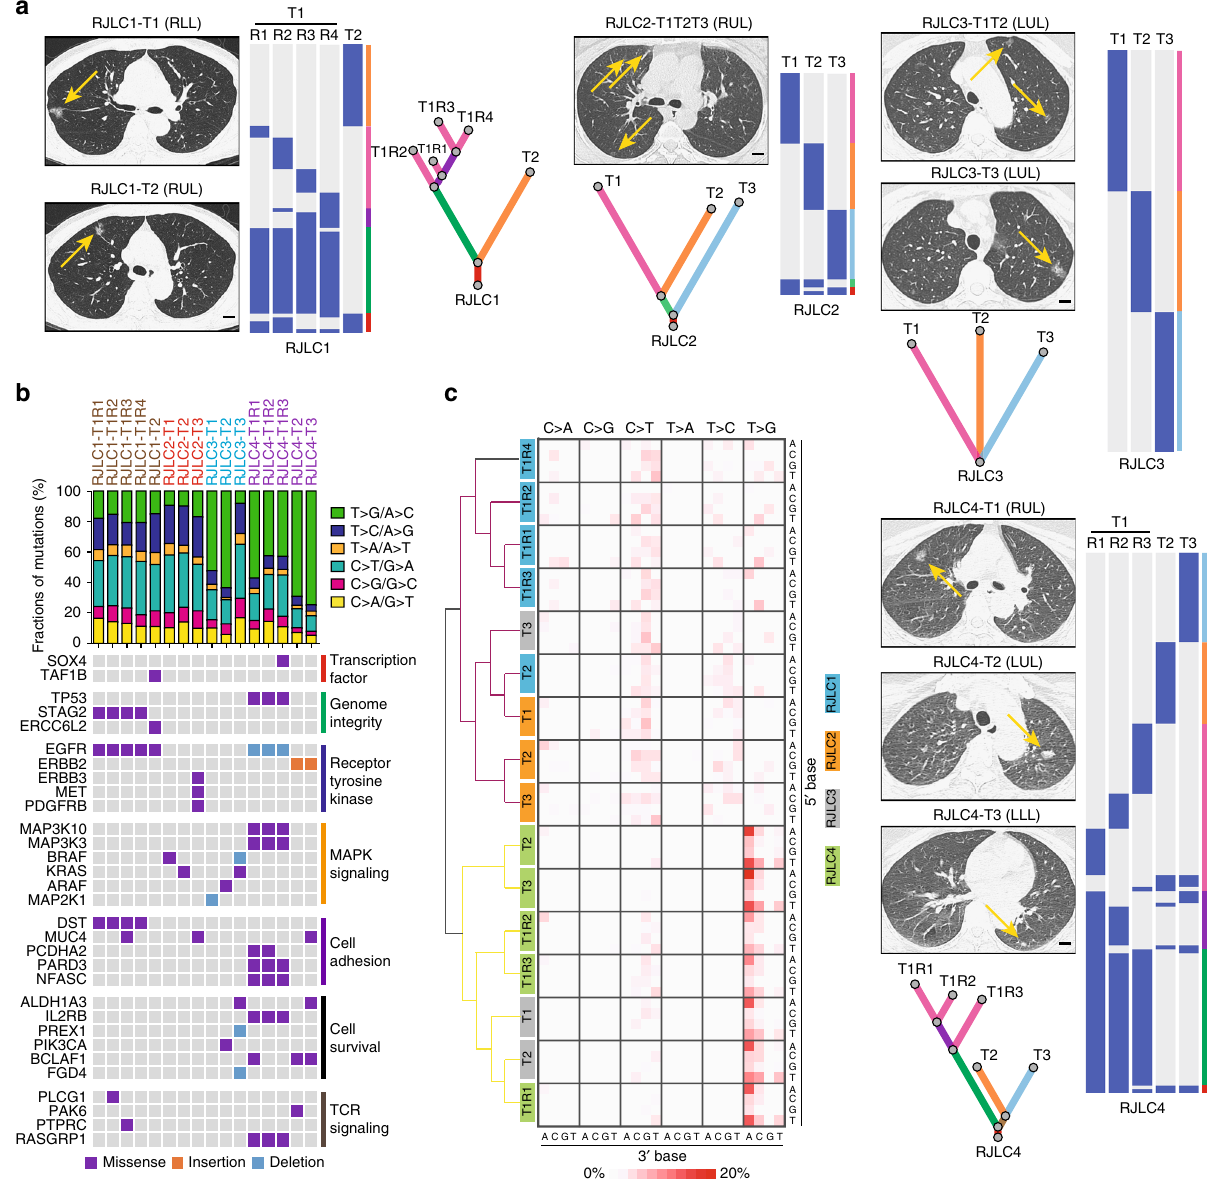
Fig. 1 Clonal architecture and mutational landscape of MSLC. a Computed tomography (CT) diagnosis and clonal architecture of multifocal tumors in four MSLC patients. Heat maps showed the presence (blue) or absence (gray) of all non-silent somatic mutations in every tumor region. Phylogenetic trees indicated the clonal structure of sequenced tumor regions in each patient. Scale bar, 1 cm. b Mutational landscape of all 16 sequenced tumor regions. Putative driver genes with somatic mutations were classi fi ed according to the functional categories. c Frequencies for each of the six substitutions at all 16 possible trinucleotide contexts were displayed in a heat map. All specimens were separated into two major clusters based on the mutational